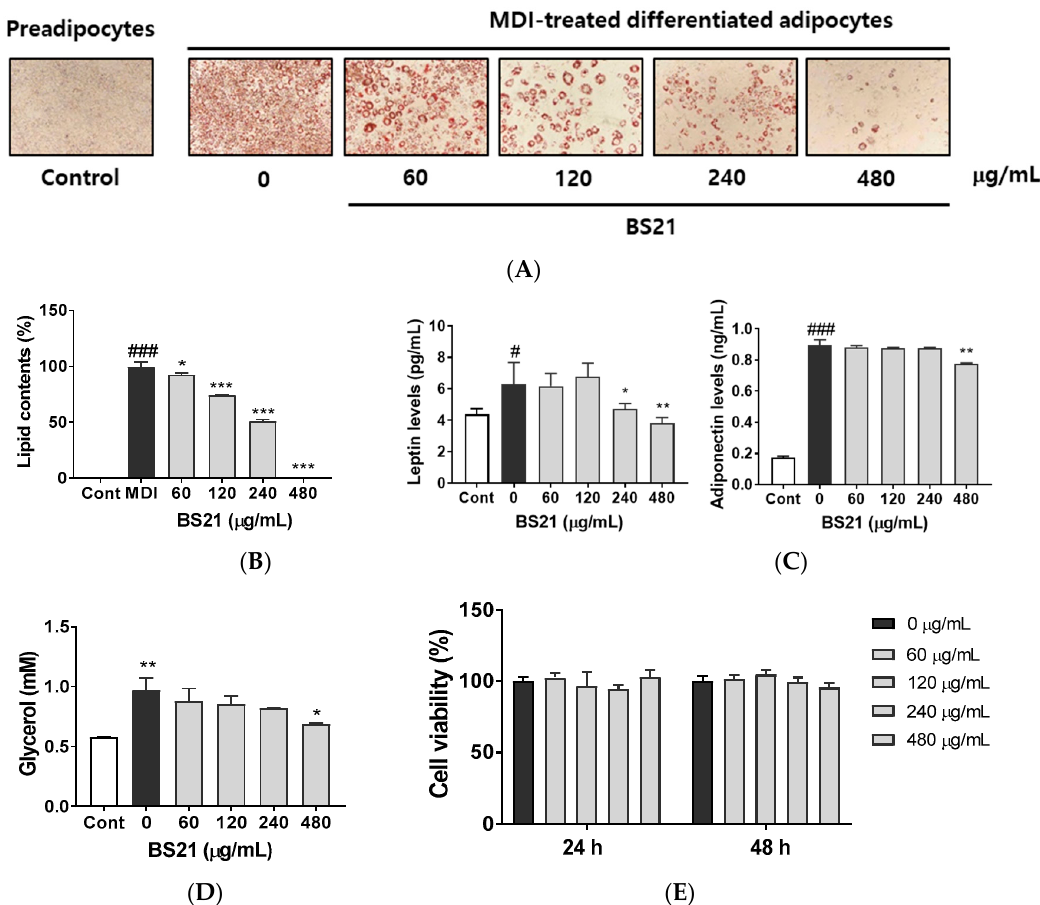
Figure 1. Effect of a 2:1 mixture of Phyllostachys pubescens and Scutellaria baicalensis (BS21) on adipocyte differentiation in 3T3-L1 cells. ( A ) Oil Red O staining of intracellular triglycerides in 3T3-L1 cells. 3T3-L1 cells were treated with BS21 (60, 120, 240, and 480 µg/mL) during differentiation induction. ( B ) Relative densities of lipid contents. ( C ) Leptin and adiponectin levels in cell supernatants. ( D ) Glycerol levels in differentiated cells. ( E ) Cell viability. Values are expressed as means ± SD ( n = 3). Significant differences were observed between control (undifferentiated preadipocytes) and differentiated MDI (3-isobutyl-1-methylxanthine, dexamethasone, and insulin) cells: # p < 0.05, ## p < 0.01, and ### p < 0.001. Significant differences were observed between differentiated MDI cells and BS21-treated cells: * p < 0.05, ** p < 0.01, and *** p < 0.001.